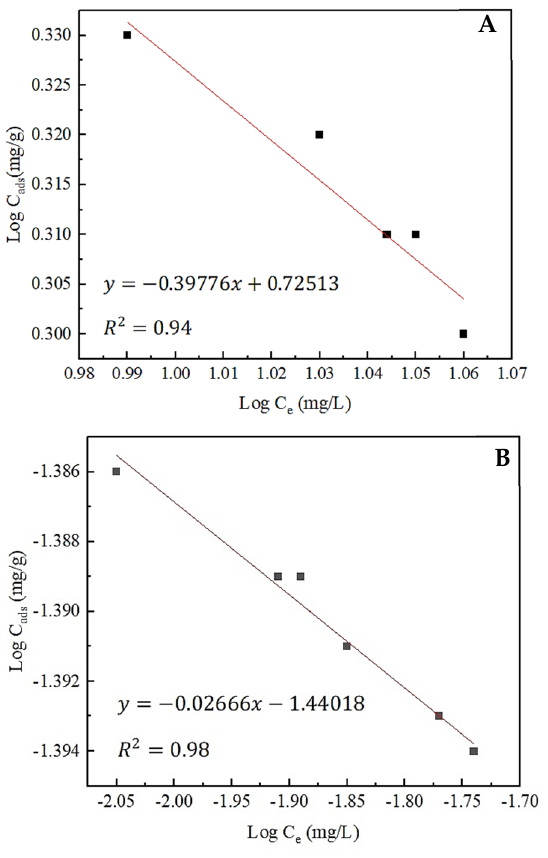
Figure 12. Freundlich adsorption isotherms of ( A ) total rare earths and ( B ) thorium onto zeolite. Dubinin–Radushkevich (D–R) adsorption isotherms of total rare earths and thorium are shown in Figure 13. The mean adsorption energy calculated from the isotherms reveals supplemental information on adsorption behavior. If the mean adsorption energy value falls between 1 and 8 kJ/mol, it is considered physical adsorption. On the other hand, if the value varies between 9 and 16 kJ/mol, it represents chemical adsorption [51]. The mean adsorption energy (E) values of rare earths and thorium were calculated as 5.8 kJ/mol and 1.80 × 10 − 3 kJ/mol, respectively. E < 8 kJ/mol indicates that both rare earth and thorium adsorption is governed by reversible physisorption and requires less energy. Intermolecular forces are involved in accomplishing the adsorption. Moreover, the activity coefficient values were found to be − 1.48 × 10 6 mol 2 /kJ 2 and − 1.54 × 10 − 5 mol 2 /kJ 2 for total rare earths and thorium,